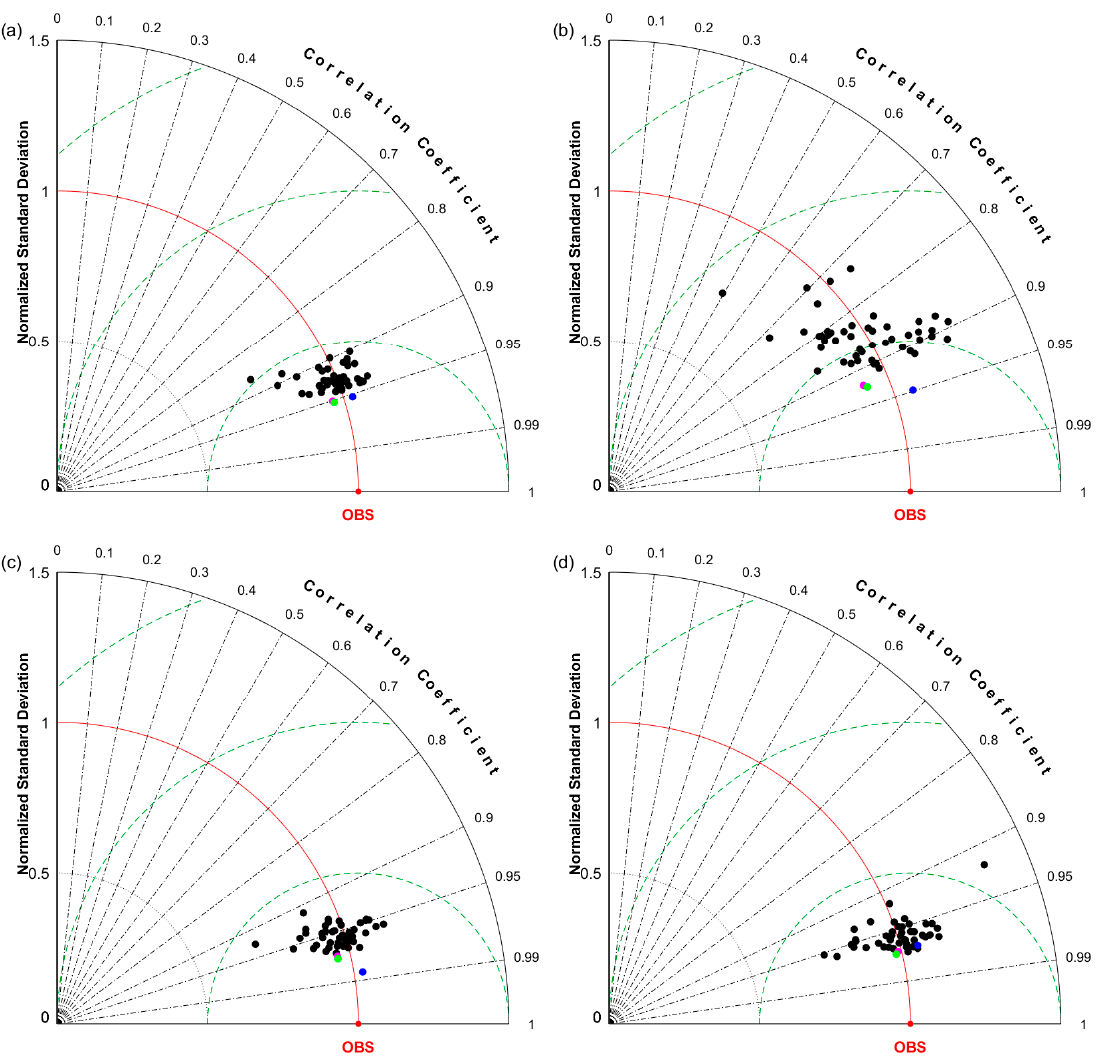
Figure 12. Taylor diagram of the estimations from the SMA method, the BMA method, the CERES EBAF, and the 48 GCMs over high-latitude areas from 2000 to 2005 in the Northern Hemisphere. The SMA method, the BMA method, the CERES EBAF, and the 48 GCMs are represented by purple, green, blue, and black dots, respectively. ( a ) Spring, ( b ) Summer, ( c ) fall, ( d ) winter.